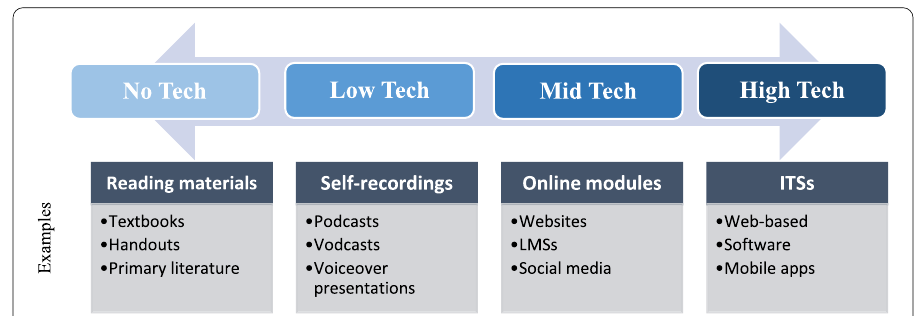
Fig. 1 The continuum of technology complexity for preparing the out-of-class content of FI, deduced